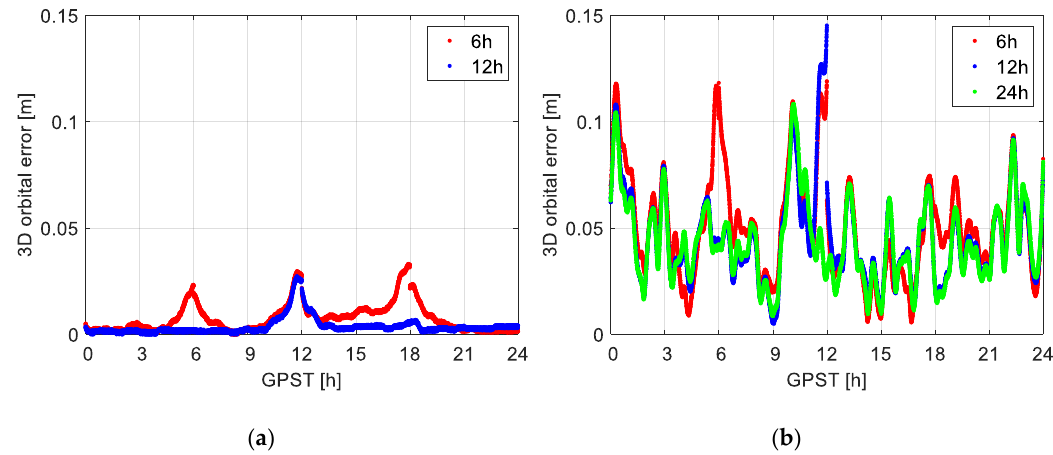
Figure 13. 3D orbital errors computed with different arc lengths using ( a ) the IGS final products and ( b ) the IGS rapid products. A duty-cycle of 100%, an observation interval of 10 s, and a mean satellite number of 9 were assumed for the processing. The arc length experiment here refers to the processing using e.g., k hours of data in each processing round, and in each hour of these k hours, data are tracked in X % of the time.